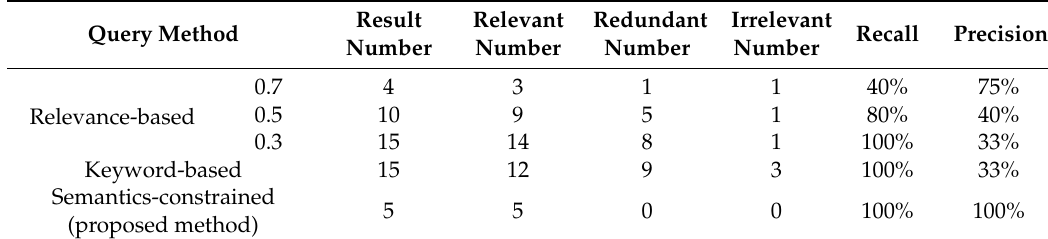
Table 2. Evaluation of selection